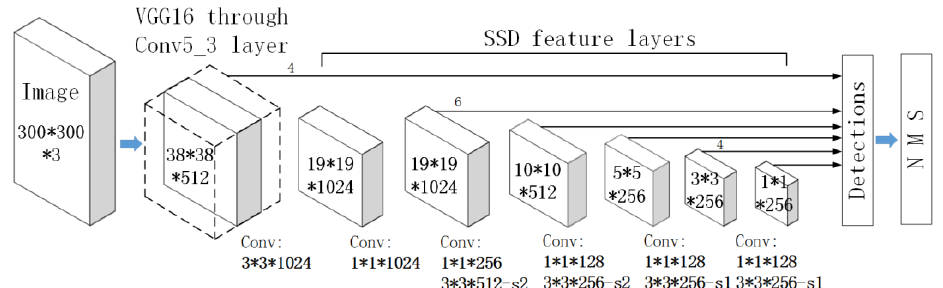
Figure 5. Single Shot MultiBox Detector (SSD) network structure.